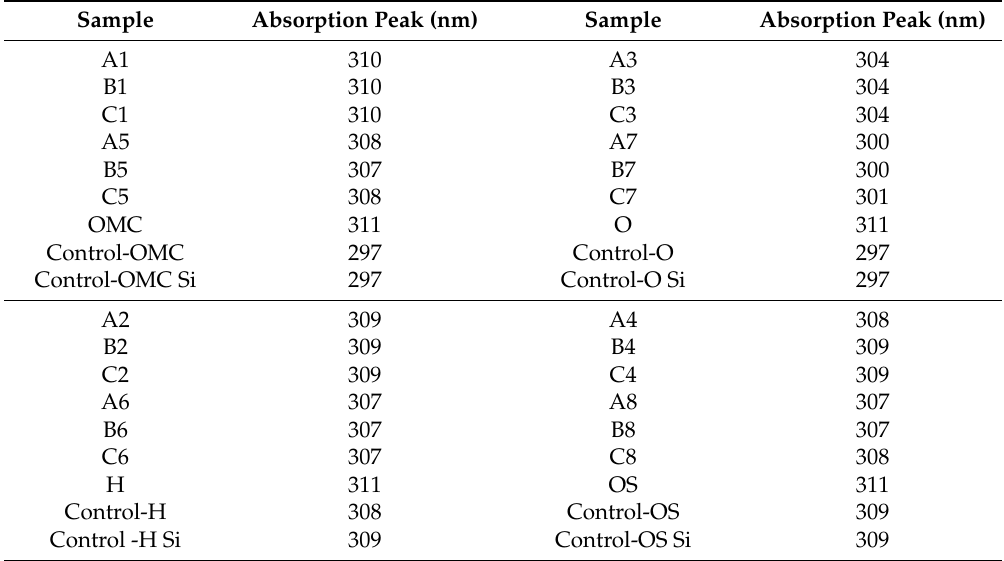
Table 4. Absorption peak of sunscreens, ultraviolet (UV) filters, and control formulas.